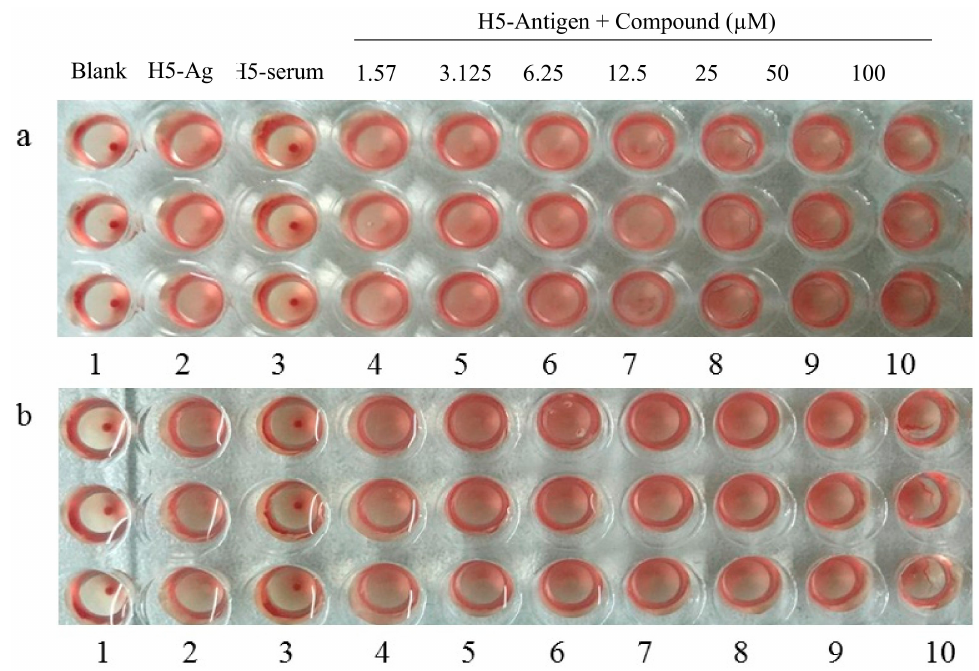
Figure 7. The hemagglutination inhibition e ff ects of derivatives. ( a , b ) respectively represent the activity of XC-27-1 and XC-27-2 in inhibition of H5N1 influenza virus-induced aggregation of chicken erythrocytes. In the plates, the H5-antigen group in the the 2nd column had the H5 antigen added. The positive control group in the 3rd column had the H5 serum added. From the 4th to the 10th column, wells were treated from left to right with XC-27-1 and XC-27-2 at 1.57, 3.125, 6.25, 12.5, 25, 50, 100 µ M, respectively. The results of the hemagglutination inhibition assay are shown in the photograph of Figure 7. The experiments were repeated independently at least three